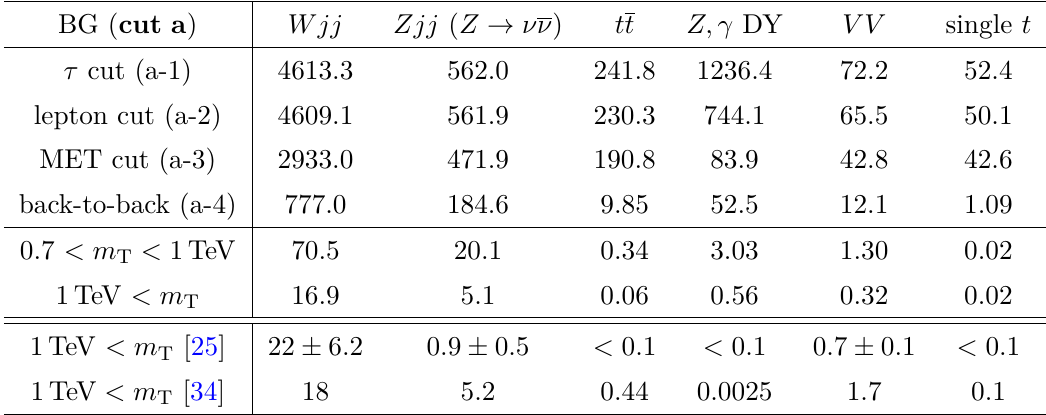
Table 9 . Cut flows of the SM background events in the cut a category (the τ ± ν search). The two rows show the results by refs. [25] and [34]. See, the main text for the